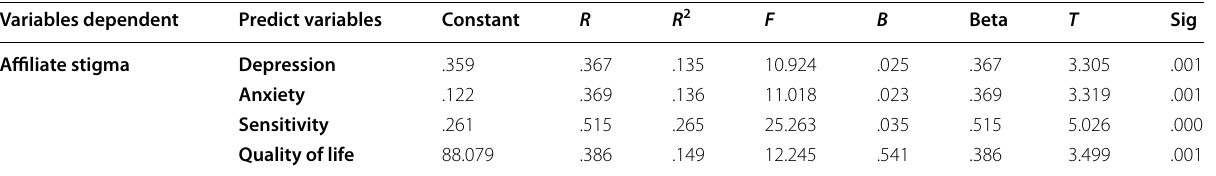
Independent variables are depression, anxiety, sensitivity, and quality of life, while dependent variables are affiliate stigma ADHD attention-deficit hyperactivity disorder, ASD autism spectrum disorder